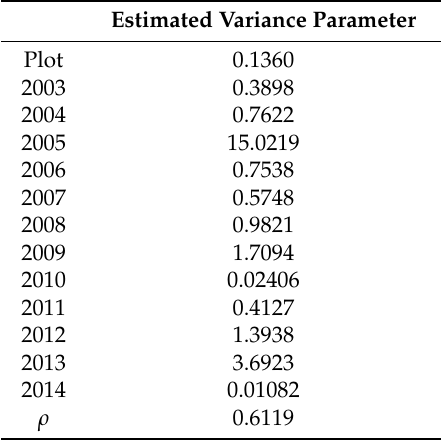
Table 5. Variance parameters of the linear mixed